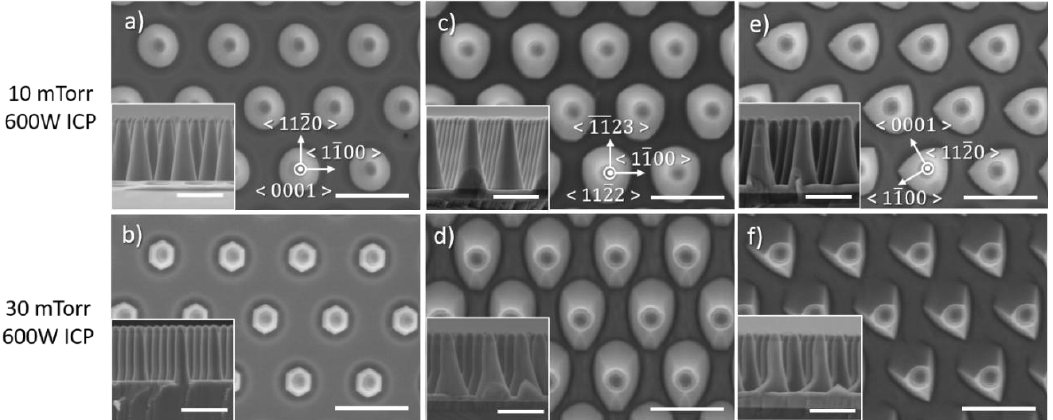
Figure 6. Plan view and cross-sectional (inset) SEM image of GaN nanorod etch series 3 under di ff erent chamber pressures for ( a , b ) c -plane ( c , d ) (1122) semi-polar and ( e , f ) (1120) non-polar GaN layers. Scale bar is 1 µ